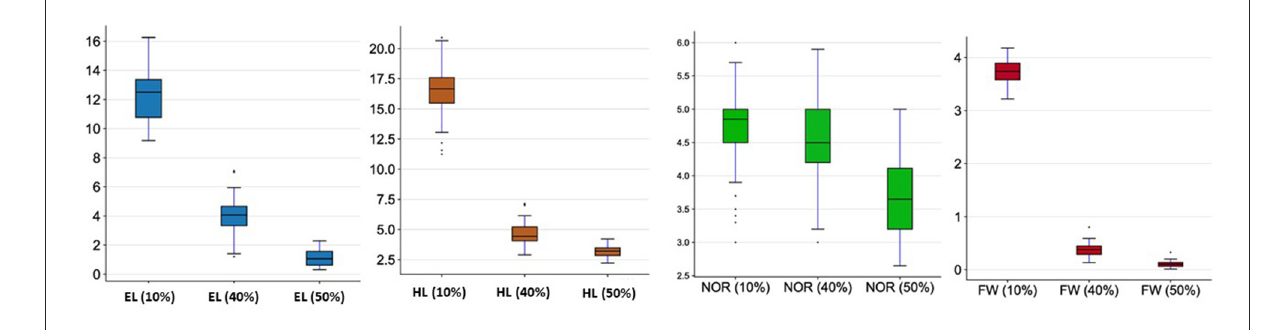
FIGURE1 Seedling development under different seawater concentrations (10, 40, and 50%). For abbreviations see Table 1.